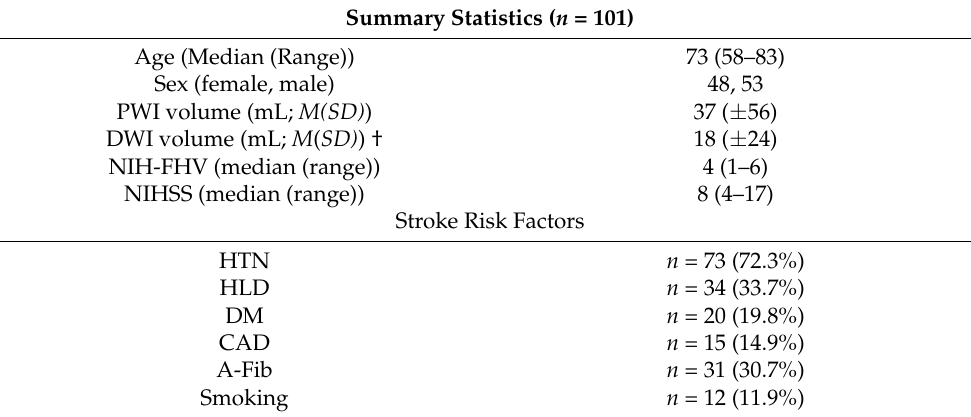
Table 1. Participant characteristics.